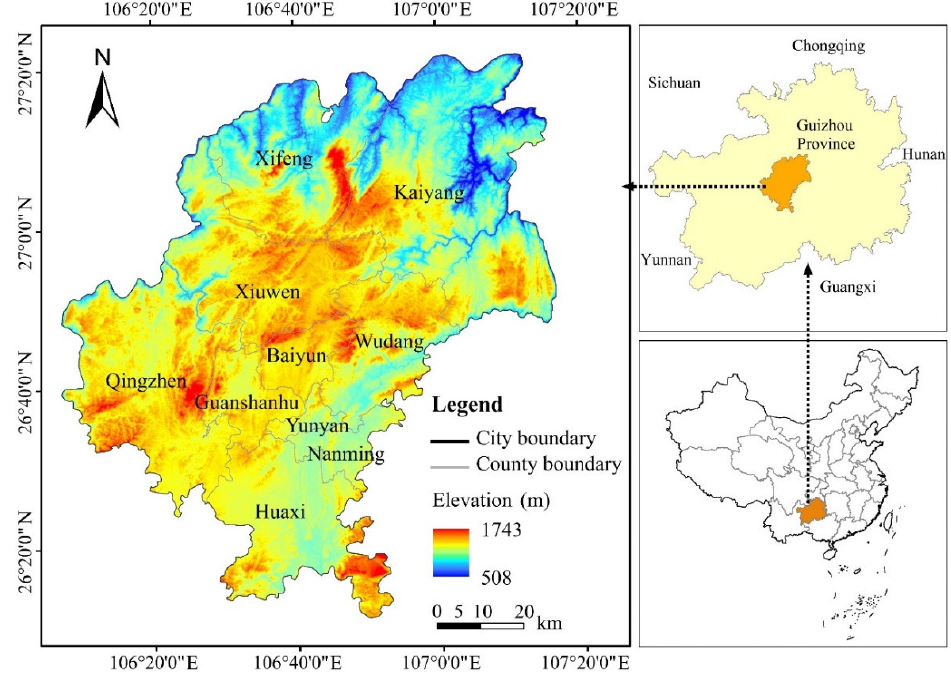
Figure 1. Geographic location and elevation of Guiyang City.